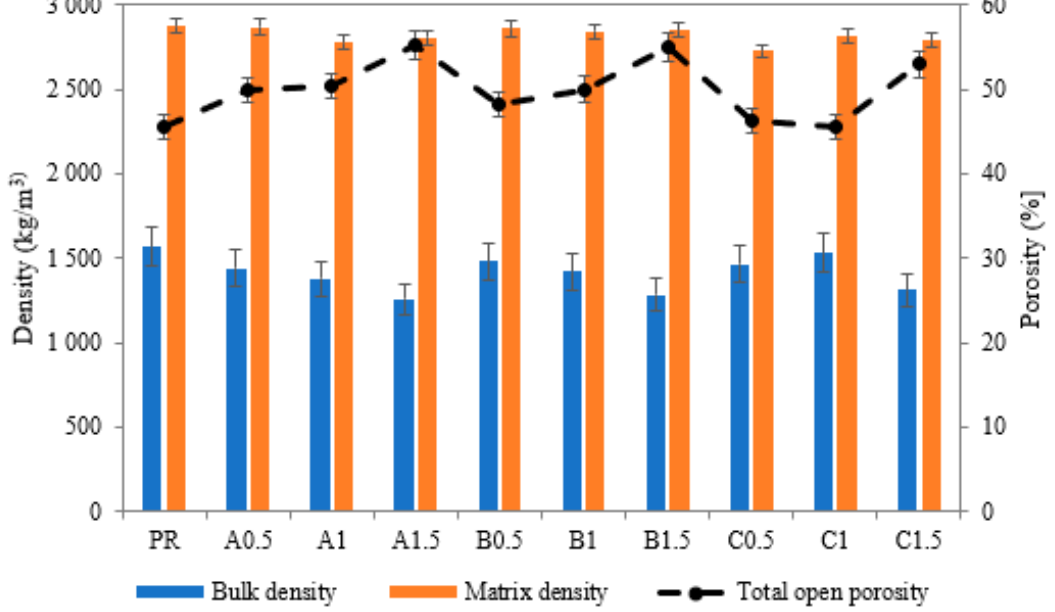
Figure 7. Basic material properties of lime-based plasters modified by SAPs.